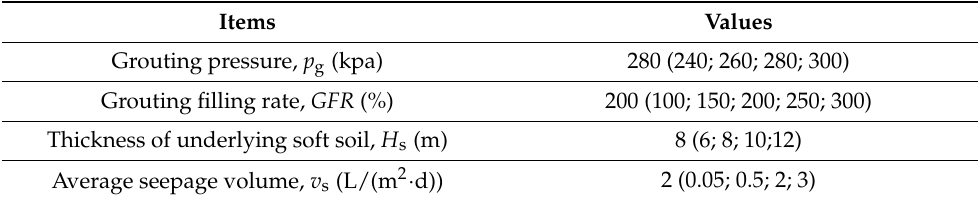
Table 6. Parameters for sensitivity